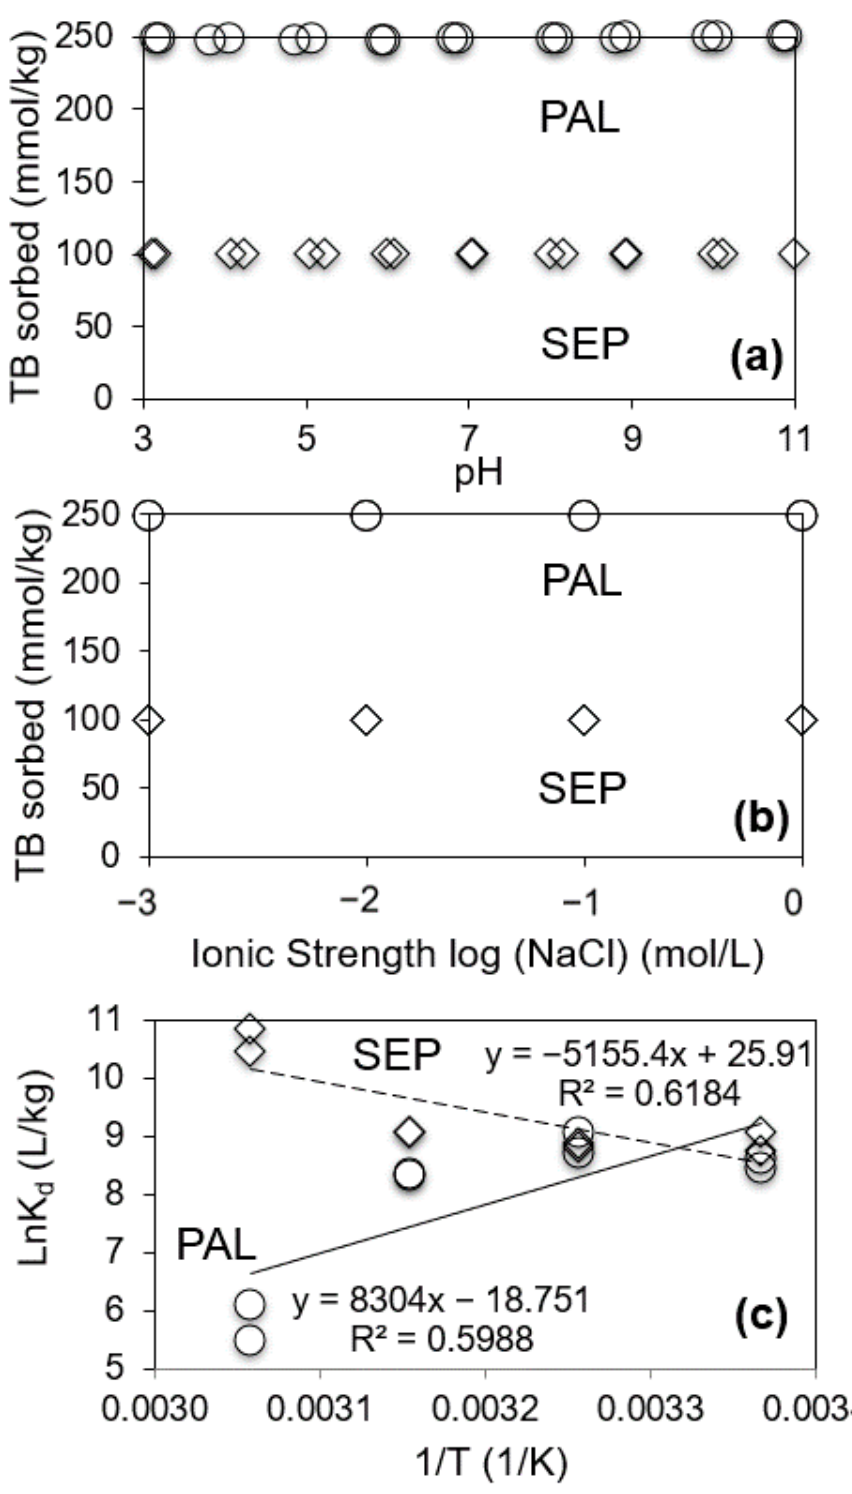
Figure 4. Influence of equilibrium solution pH ( a ), ionic strength ( b ), and temperature ( c ) on TB sorption on PAL and SEP. Table 1. Thermodynamics of TB sorption on PAL and SEP.